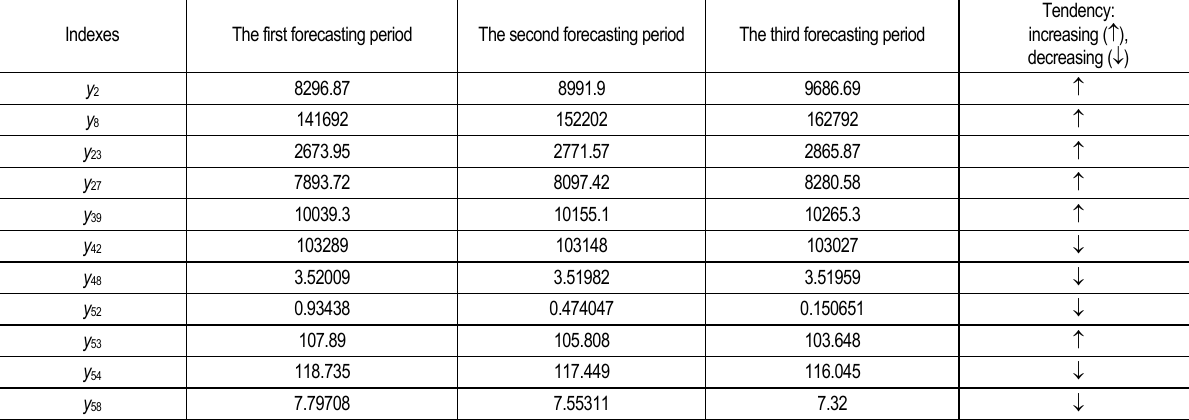
Table 7. Forecasting meanings of indexes of socioeconomic development of China The first forecasting